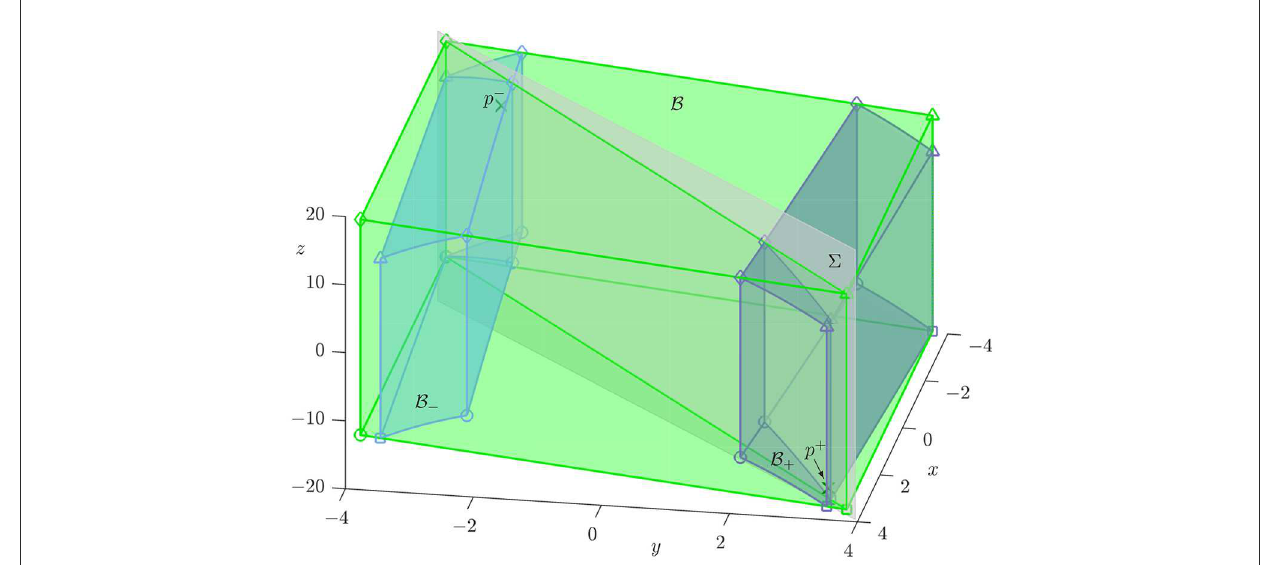
FIGURE1 Box B (green) and its preimages B − (light blue) and B + (dark blue) under H with ξ = 1.2. The x -aligned edges of B ± are labeled # , 3 , (cid:3) , and △ by their corner points according to how they map under H to the respective edges of B defined in Equations (5)–(8). Also shown are the saddle fixed points p ± (green crosses) contained in the diagonal plane 6 (gray); throughout µ = − 9.5 and β =